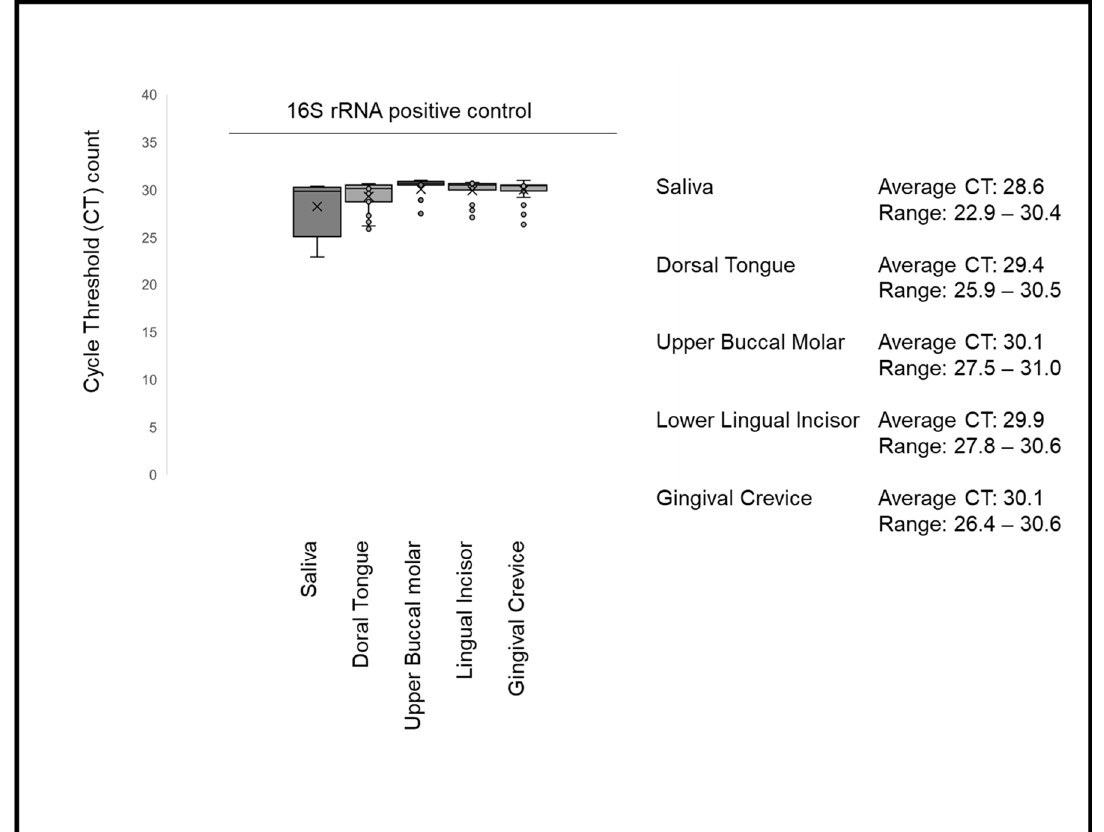
Figure 1. qPCR screening of samples for positive control 16S rRNA. All study samples harbored bacterial DNA with average cycle threshold (CT) counts ranging from 28.6 (saliva and lower lingual incisor), 29.9 (dorsal tongue), to 30.1 (upper buccal molar and gingival crevicular